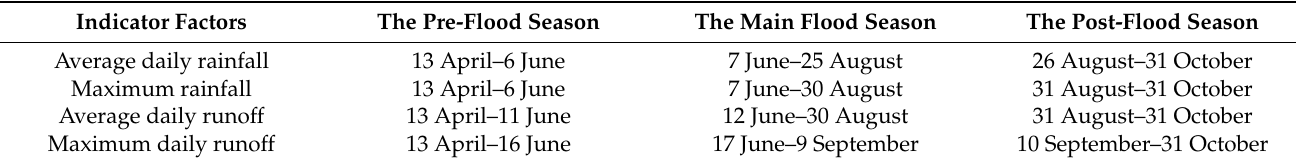
Table 6. Flood staging results for the Chengbi River